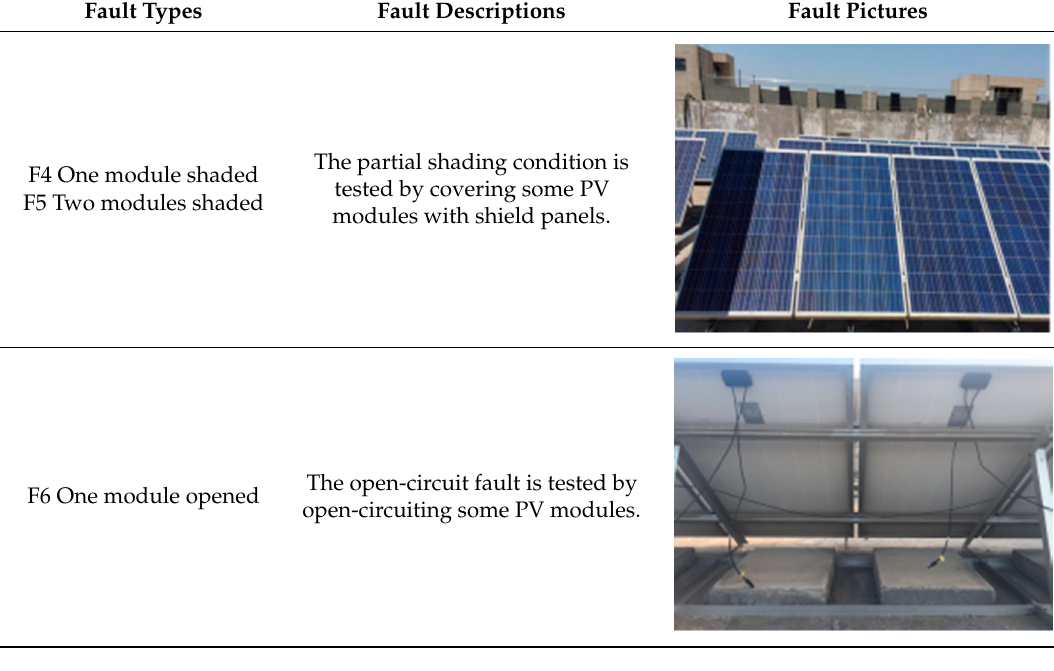
Table 12. Experimental collection distribution.